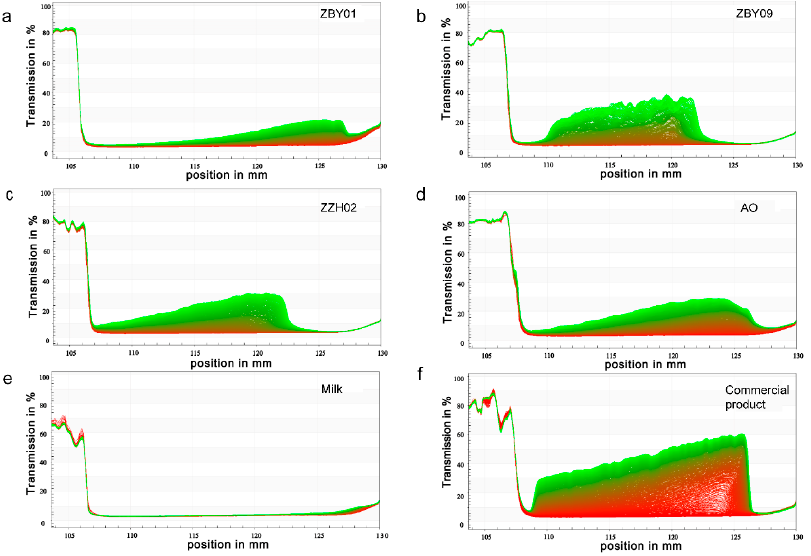
Figure 3. The stability of oat milk analyzed by using Lumisizer. ( a ), the stability of oat milk made of ZBY01; ( b ), the stability of oat milk made of ZBY09; ( c ), the stability of oat milk made of ZZH02; ( d ), the stability of oat milk made of AO; ( e ), the stability of UHT bovine milk; ( f ), the stability of commercial product. The red line in the bottom of each figure represents the first transmission record when the analysis started, the green line on the top of each figure represents the last transmission record during analysis. Table 3. Stability of oat milk produced by different cultivars, commercial product, and UHT bovine milk.